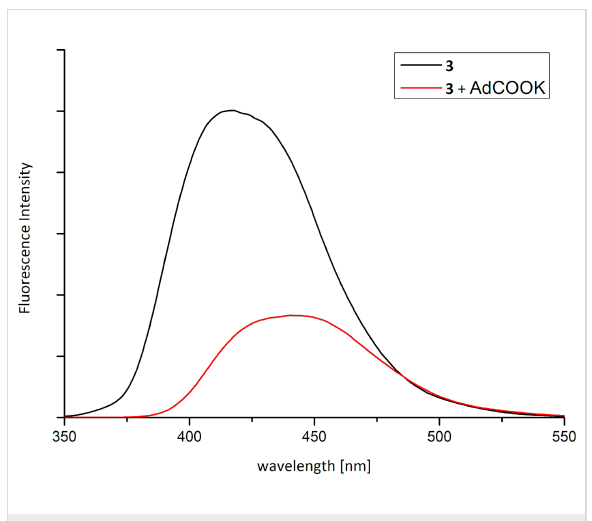
Figure 3: Fluorescence spectrum of 3 (4 × 10 − 4 M) with and without a 10-fold excess of 1 - adamantanecarboxylic acid.